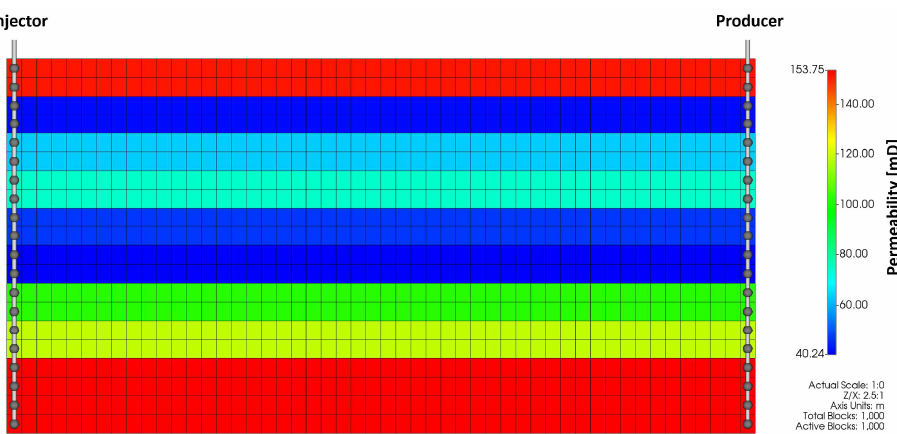
Figure 1. 2D synthetic reservoir cross-section showing the geologic layers, grid discretization, permeability distribution, and well